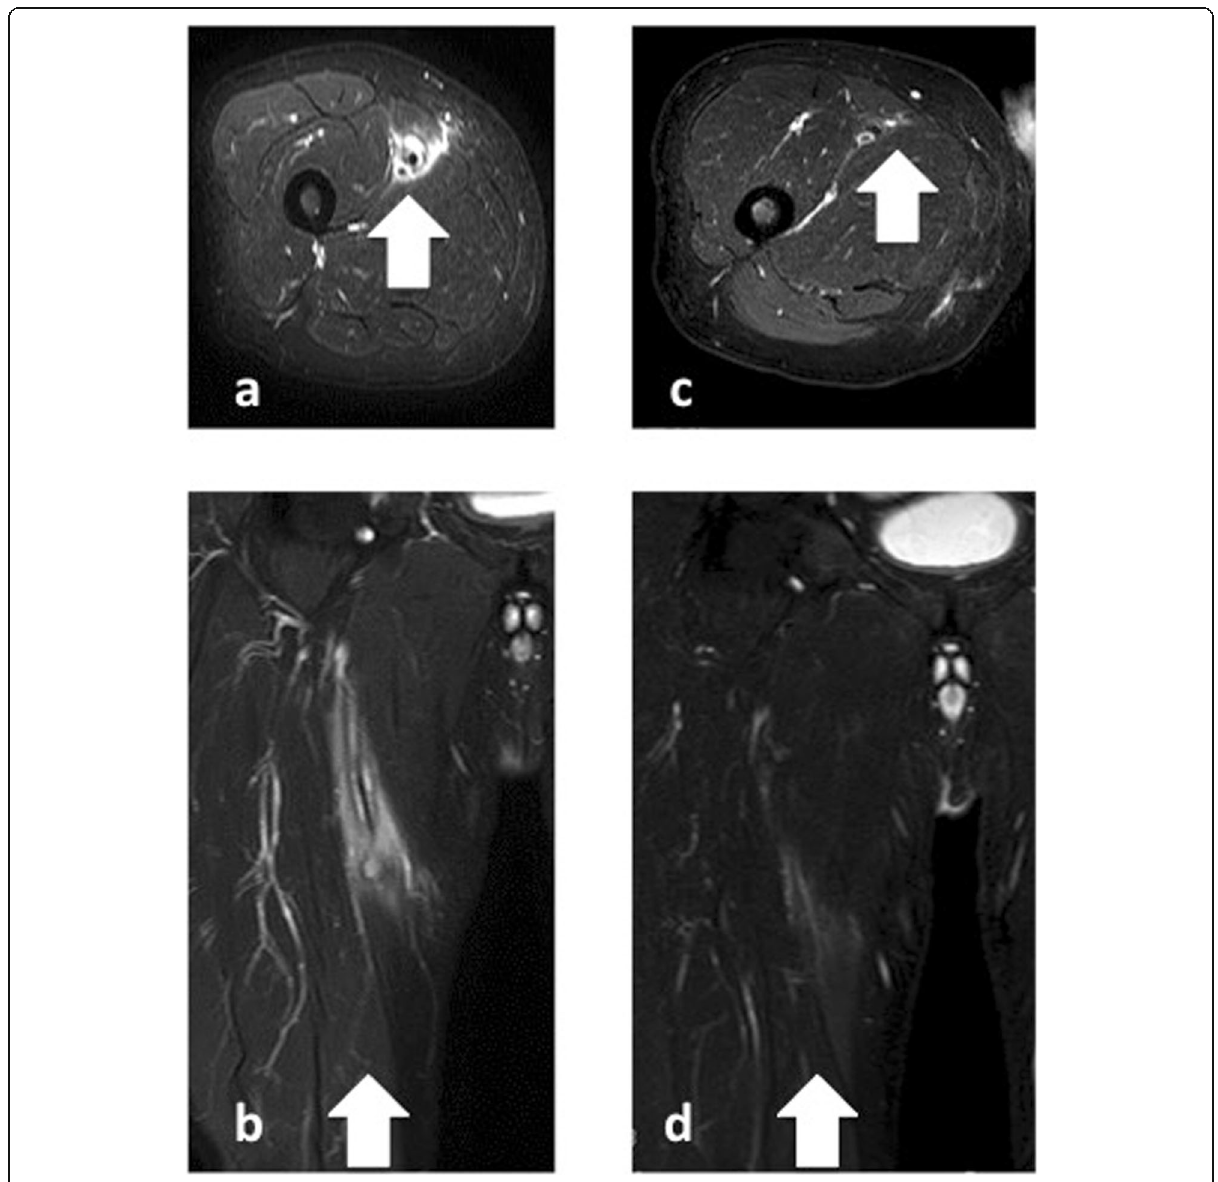
Fig. 3 Serial magnetic resonance imaging scans of the right thigh. a , b Seven days after anti-inflammatory medication was begun. c , d Three months later. Note the progressive reduction in soft-tissue edema (arrows) surrounding the right superficial femoral